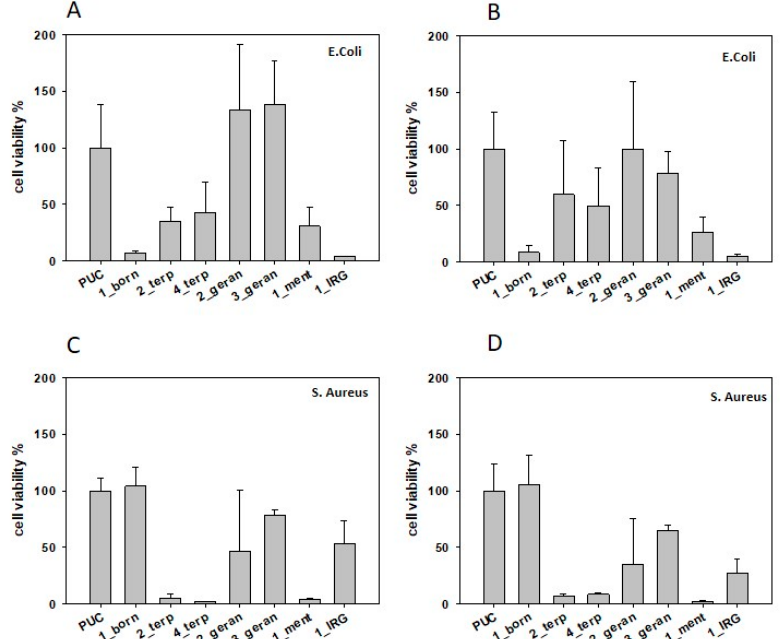
Figure 3. Percentage of cell viability of planktonic ( A , C ) and sessile ( B , D ) E. Coli and S. Aureus